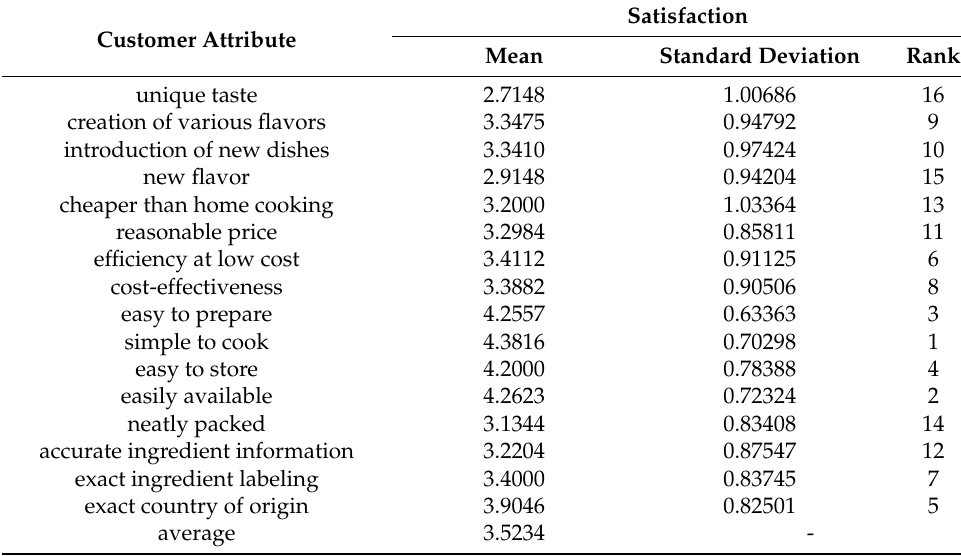
Table 4. The satisfaction results of HMR